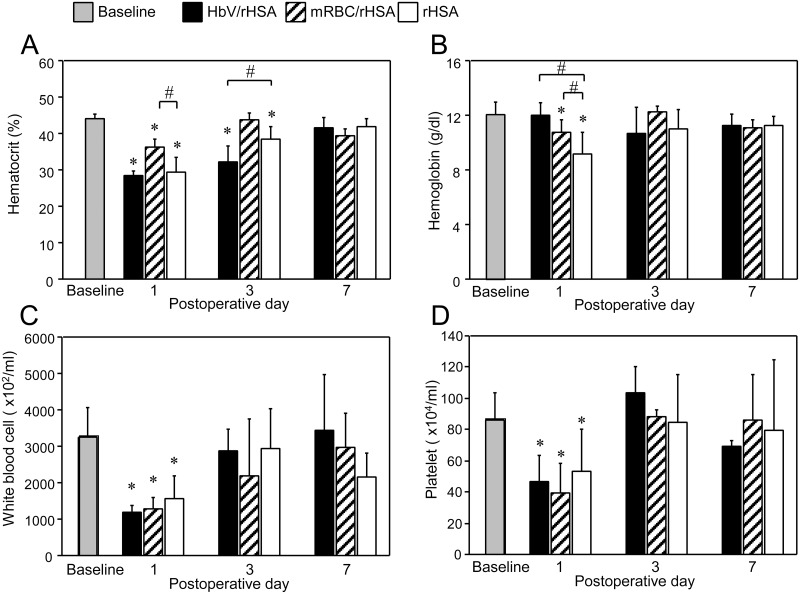
Changes in (A) hematocrit levels, (B) hemoglobin concentrations, (C) white blood cell counts, and (D) platelet counts between the baseline period and the 7th postoperative day (POD) in the indicated study groups.Values are shown as the mean ± SD. n = 10 in each group. *P < 0.05 versus baseline (Student’s t-test), #P < 0.05 versus the rHSA group (Dunnett’s test).